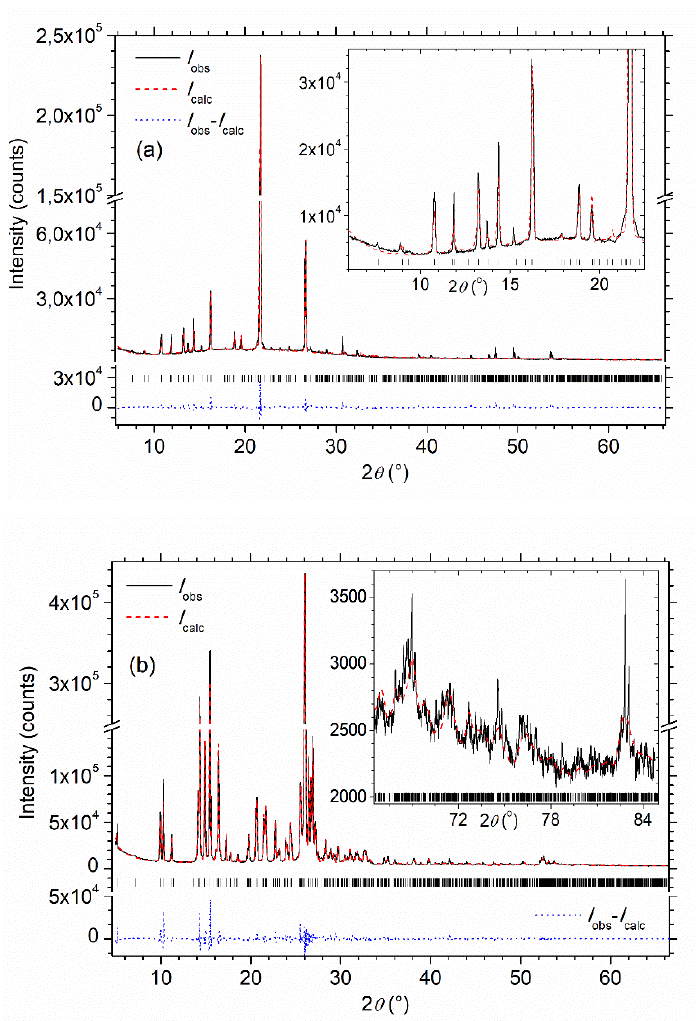
Figure 6. ( a ) MBI-phosphate-1, ( b ) MBI-phosphite. Experimental XRD pattern (I obs ), superimposed with the one calculated by means of Rietveld fitting (I calc ). The I obs - I calc di ff erence diagram is shown below. Angle positions of the Bragg reflections calculated according to refined unit parameters are indicated by vertical bars. The inserts show the experimental and calculated XRD patterns in a low-angle range 2 θ < 22.5 ◦ for MBI-phosphate-1 ( a ) and a high-angle range 2 θ > 66.5 ◦ of the MBI-phosphite XRD pattern ( b ) on a larger